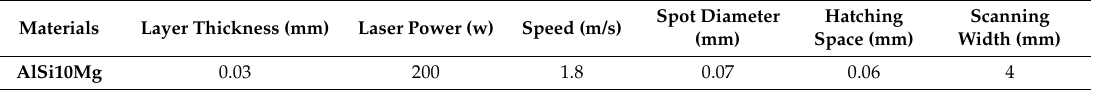
Figure 1. SEM morphologies of Al Si10Mg powder. Table 2. AM process parameters. Table 1. Chemical composition of forming material powder and base materials (wt%).